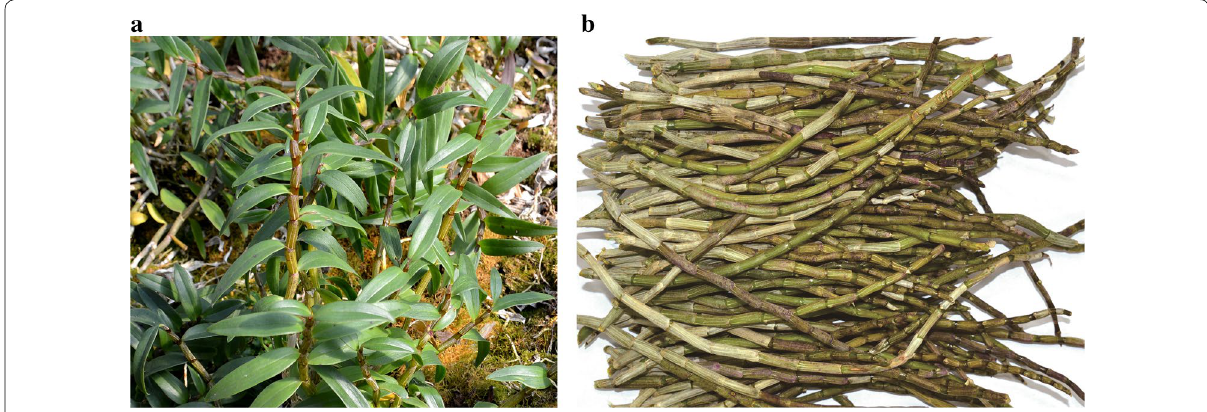
Fig. 1 Images of Dendrobium officinale ( a ), and its stems ( b